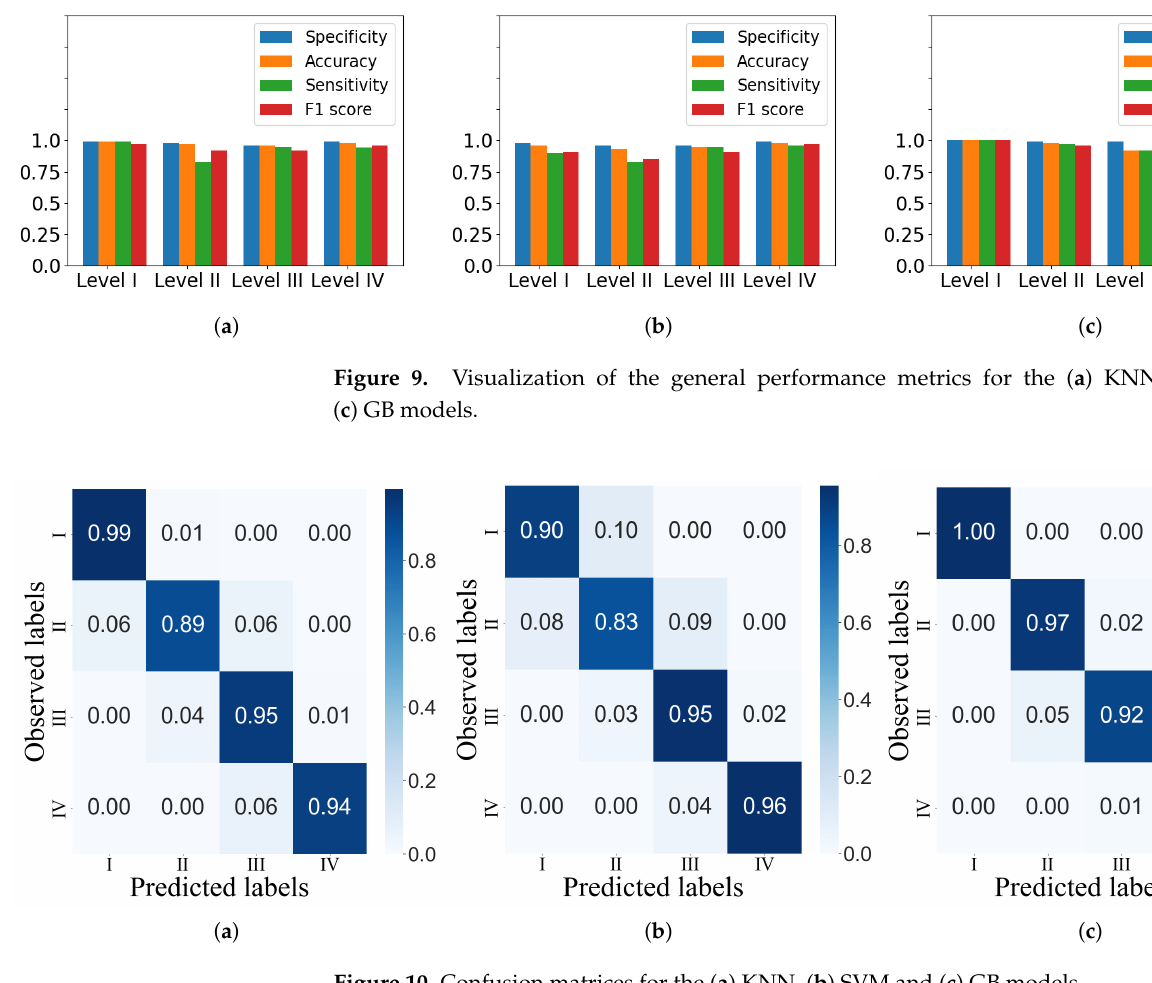
Figure 10. Confusion matrices for the ( a ) KNN, ( b ) SVM and ( c ) GB